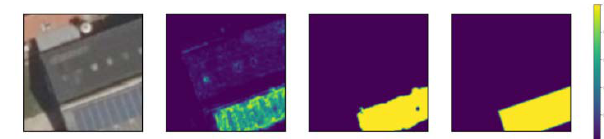
Figure 3 . Solar panel detection pipeline (left to right: input image, prediction, filtered result, ground truth).